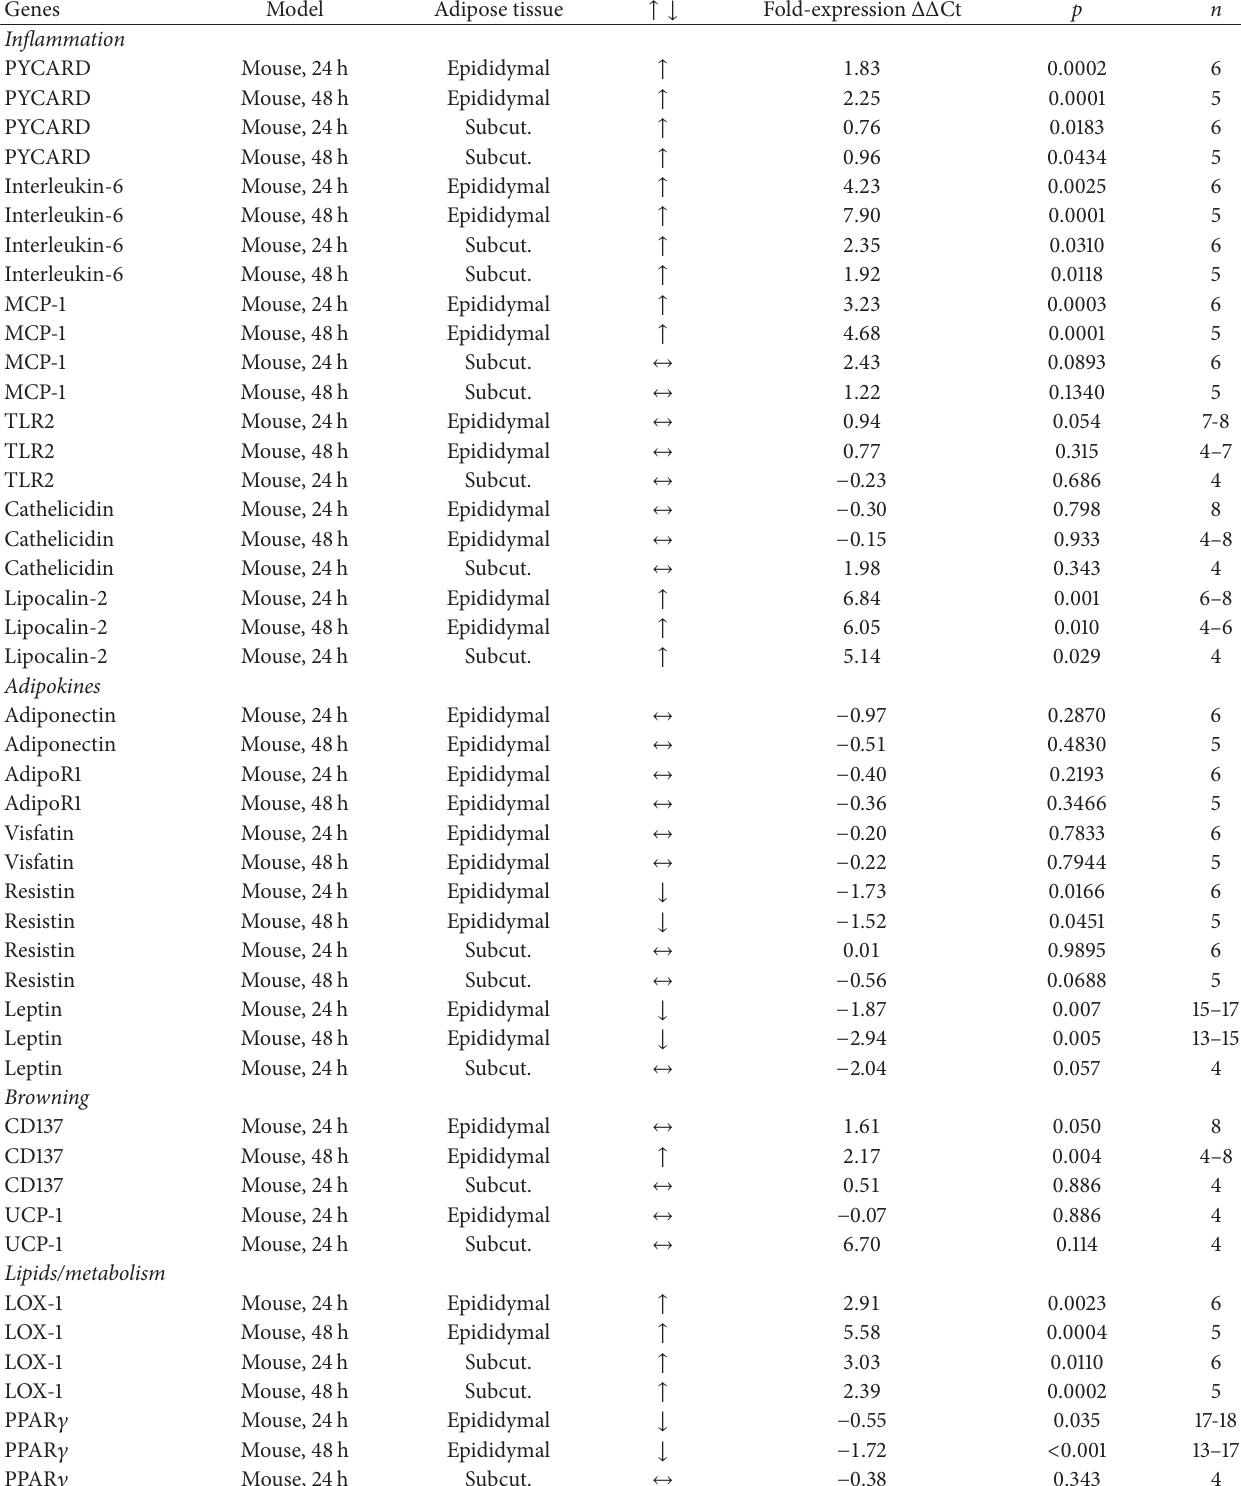
Table 2: Gene expression levels in adipose tissue from S. aureus infected peritonitis